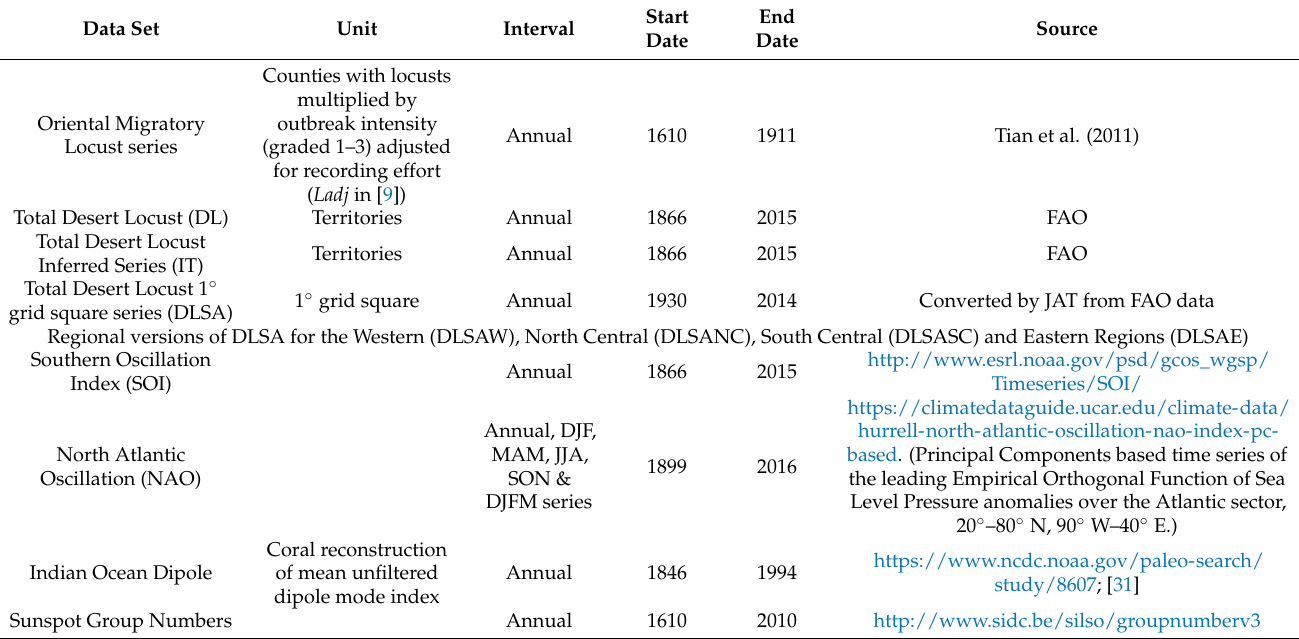
Table 1. Data sets used in the